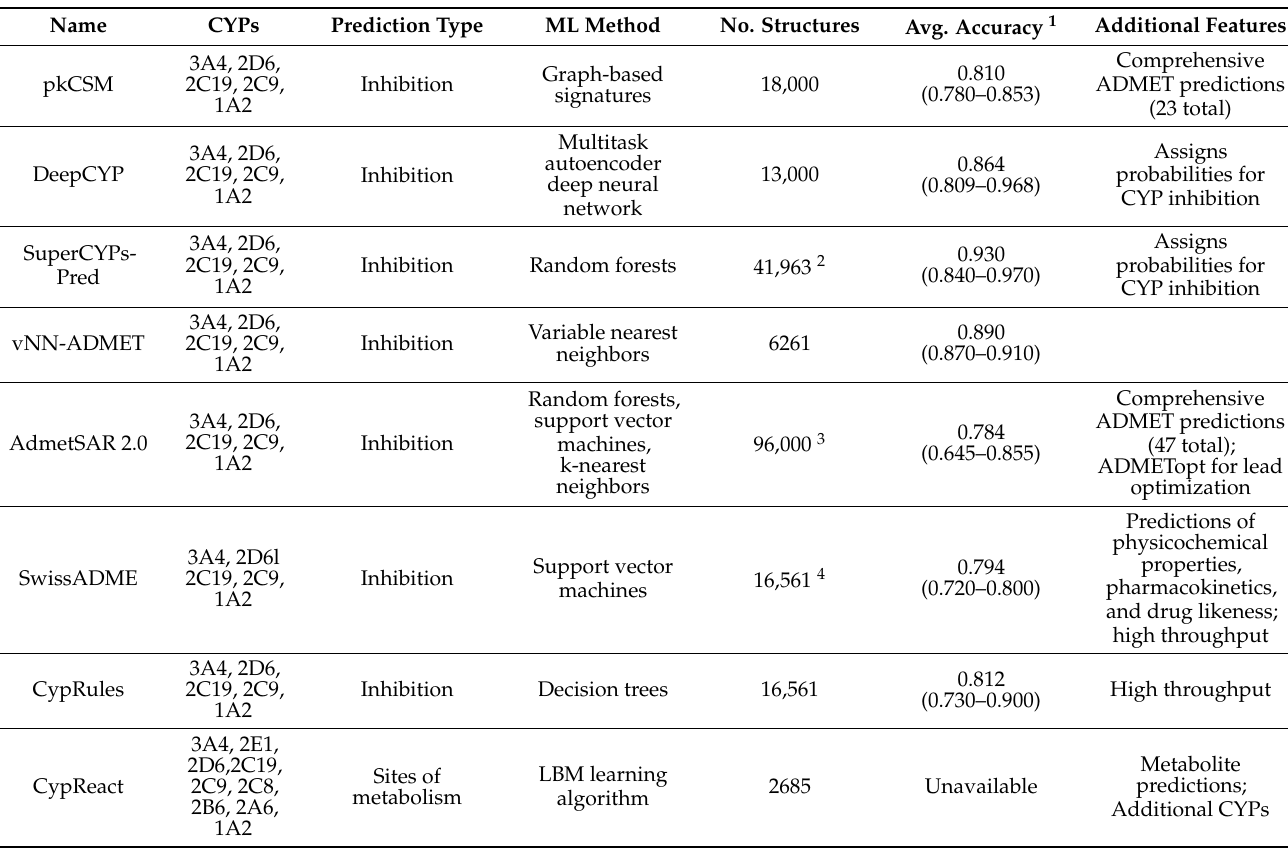
Table 2. Summary of publicly available machine learning-based methods for cytochrome inhibition and